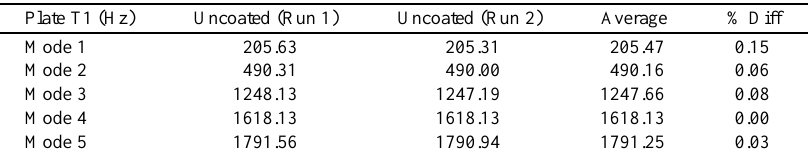
Table 3 Resonant frequencies from laser vibrometer test for plate T1 (Uncoated without strain Gages)